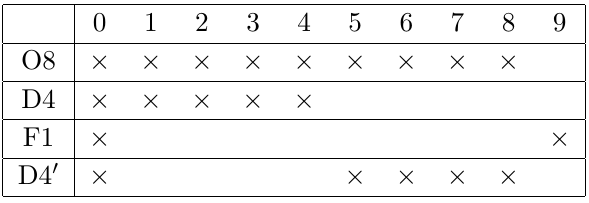
Table 1 . The directions of the various